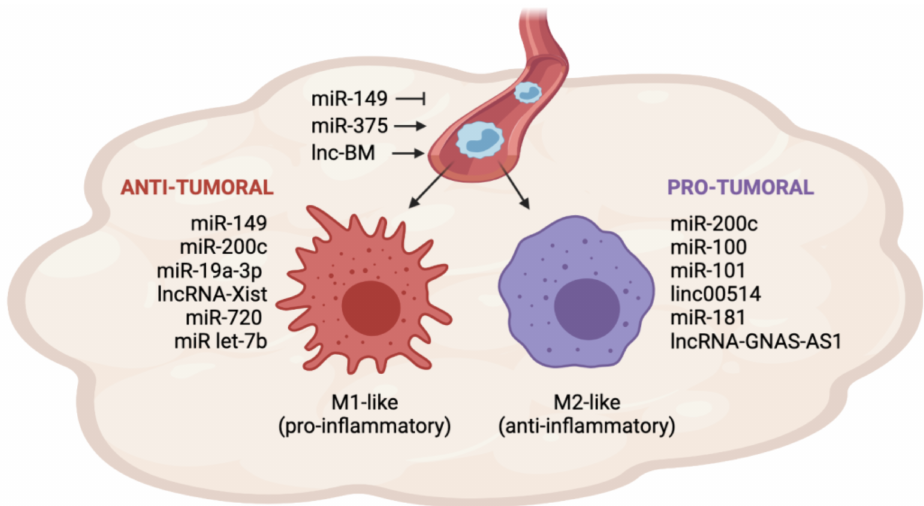
Figure 1. miRNAs and lncRNAs involved in TAM recruitment and polarization in breast cancer. The expression of miRNAs and lncRNAs in BC cells influences TAM recruitment by regulating the secretion of cytokines and chemokines in the TME. MiR-149 inhibits monocyte recruitment, whereas miR-375 and lnc-BM promote monocyte recruitment. Once in the tumor site, monocytes can differentiate into anti-tumoral (M1-like) or pro-tumoral (M2-like) macrophages. The expression of miR-200c, miR-100, miR-101, linc00514, miR-181 and lncRNA GNAS-AS1 in BC cells or TAMs promotes the differentiation into the M2-like phenotype. Conversely, the expression of miR-149, miR-200c, miR-19a-3p, lncRNA-Xist, miR-720, and miR-let7b in BC cells or TAMs promotes the differentiation into the M1-like